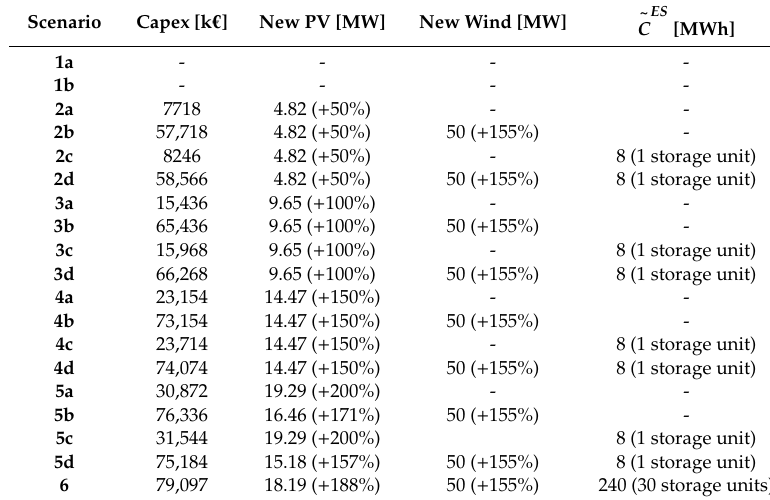
Table 5. Optimal design results.